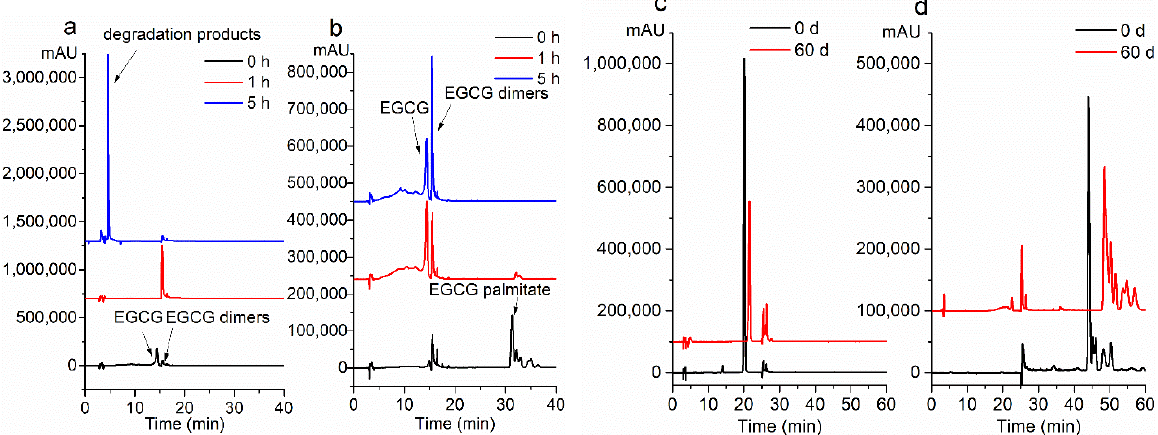
Figure 2. Stability evaluation under the alkalescent condition of ( a ) EGCG, and ( b ) PEGCG by HPLC-MS analysis. Storage stability evaluation of ( c ) EGCG, and ( d ) PEGCG by HPLC-MS analysis.